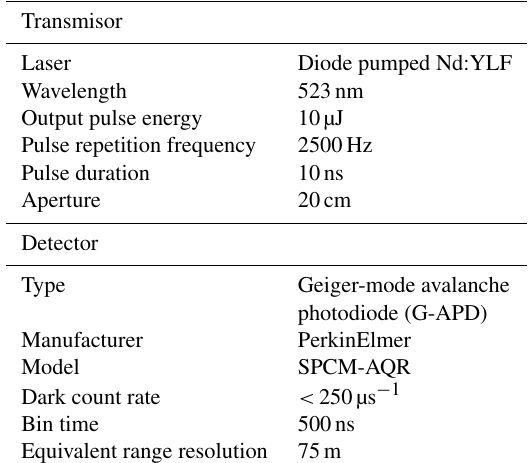
Table 1. Micropulse lidar technical